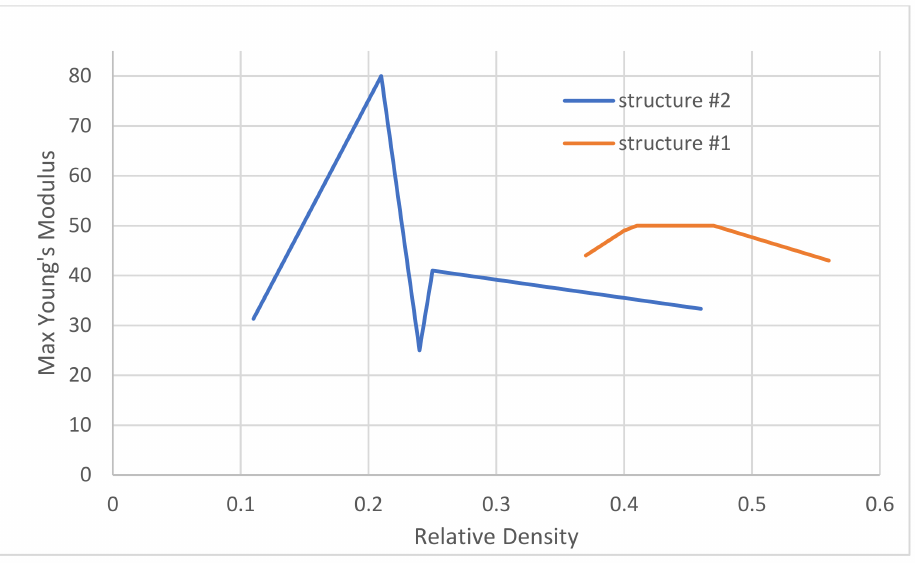
Figure 13. Maximum Young’s modulus vs. the relative density for both lattice